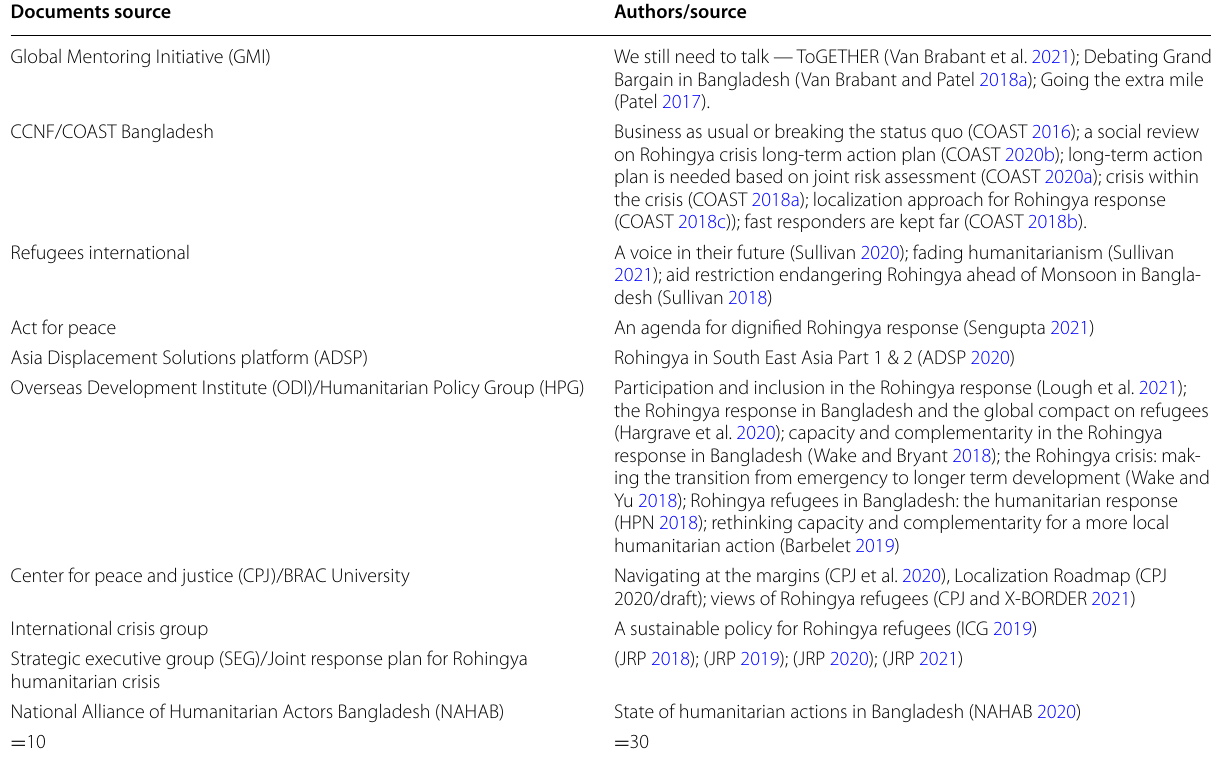
Table 1 Selected documents for analyzing localization discourse based on Rohingya response after